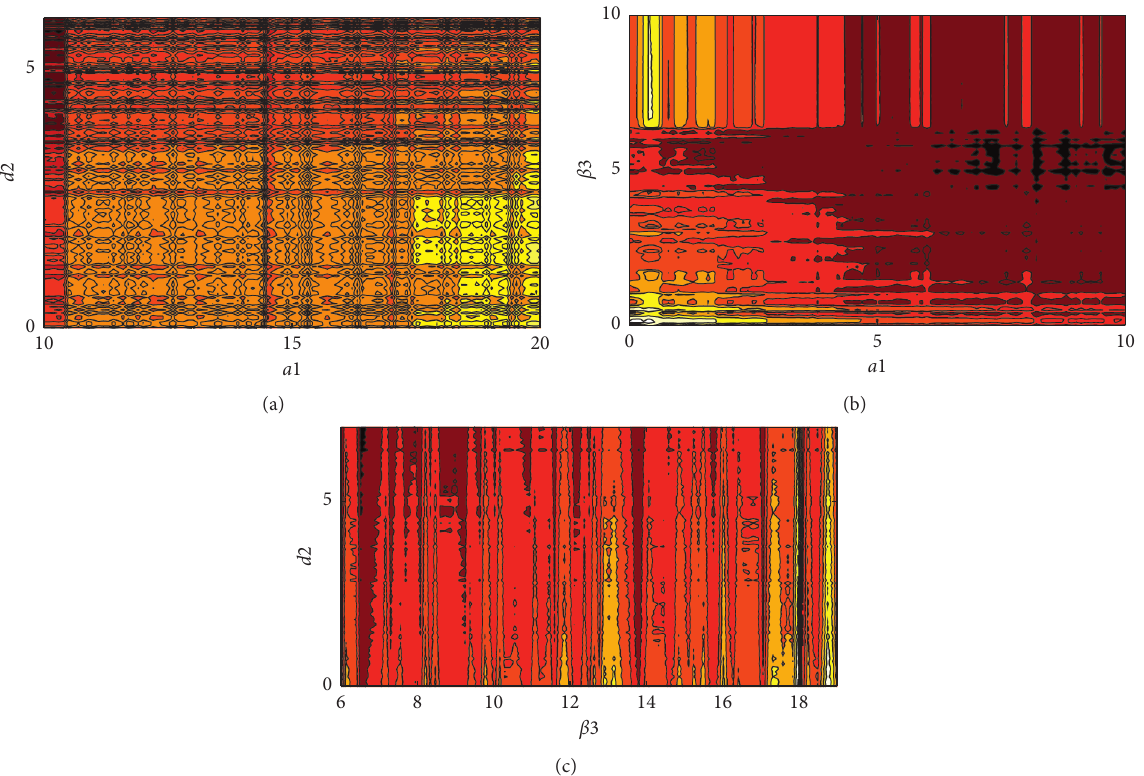
Figure 7: Spectral entropy complexity: (a) in a